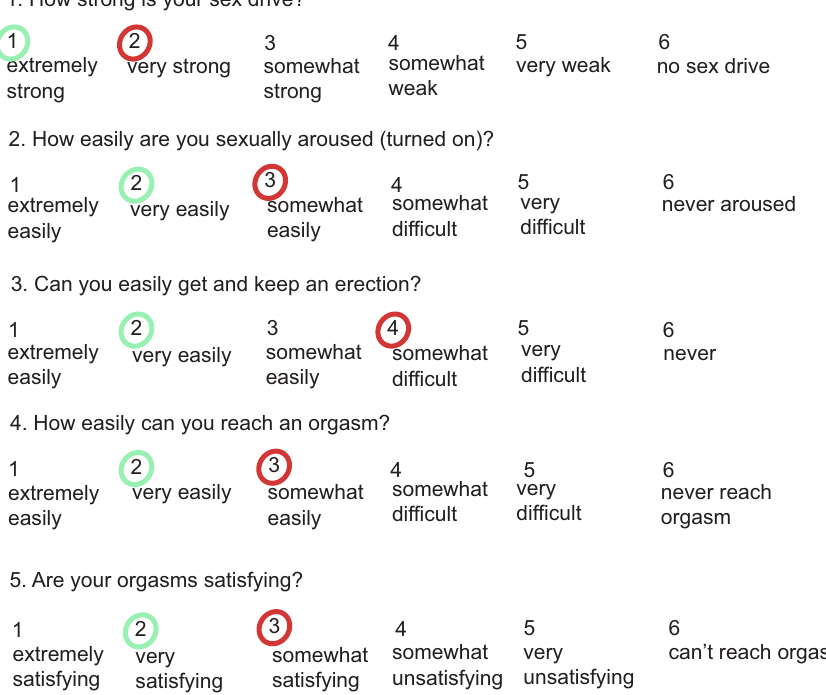
dysfunction with regards to paid sex. The question arises why